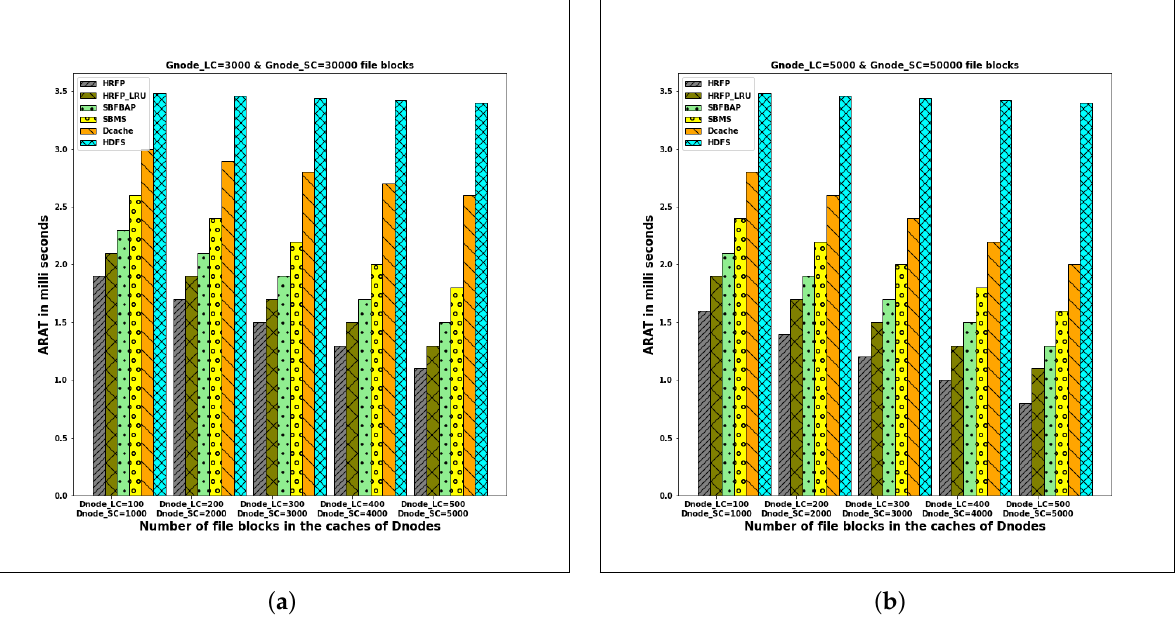
Figure 3. Figures ( a , b ) represent Average read access time in milliseconds when the size of Gnode_LC is set to 3000, 5000 file blocks and size of Gnode_SC is 30,000, 50,000 file blocks respectively.